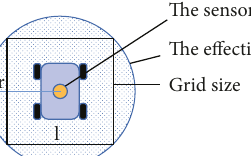
Figure 1: The schematic diagram of MCTS ( S means the next state after an action. S T means the last state and S t + 1 and task are over. Some states are printed in gray; it means there are some illegal actions. By the way, the depth from S t to different S T may be different).